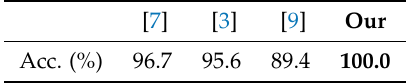
Table 6. Comparison to state-of-the-art research works using the dataset of [7].